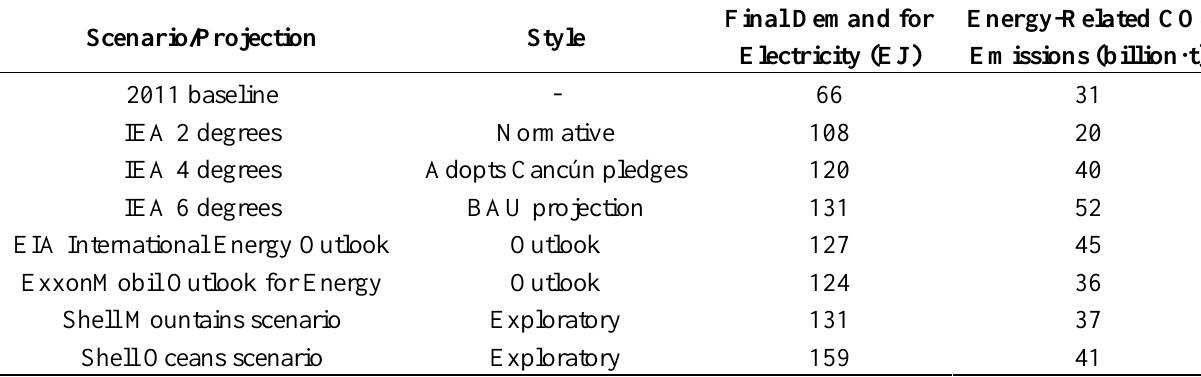
Table 1. Key scenario/projection indicators for